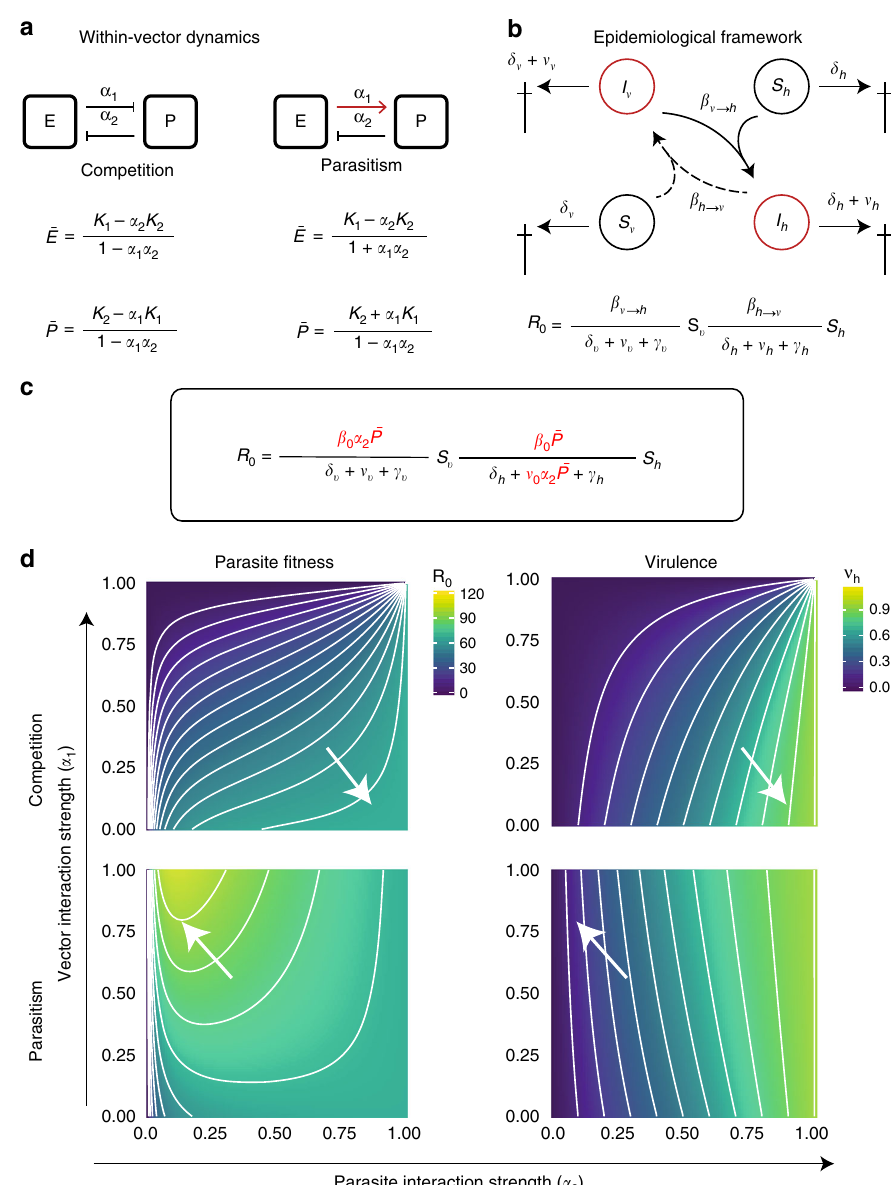
Fig. 1 Within-vector dynamics affect the evolution of within-host virulence. a Schematic representation of the within-vector model. Inside the mosquito, eggs ( E ) and parasite ( P ) allocate resources for their development, interacting in an either competitive (left) or parasitic manner (right). The densities of developed parasites and eggs depend on how strongly eggs and parasites interact with each other (i.e., their interaction strengths α 1 and α 2 ) and are determined by the steady states (cid:1) E and (cid:1) P . b Schematic representation of the epidemiological model in a human host population, where infected vectors I v (red) transmit the parasite to susceptible humans S h (black) at a rate β (solid arrows) and infected humans I h (red) transmit the disease to susceptible v ! h mosquitoes S v at a rate β (dashed arrows). For both populations, their natural death rate ( δ h and δ v ) is increased by a factor ( ν h and ν v ) representing the h ! v parasite-induced virulence. The fi tness of the parasite is then given by the basic reproduction number ( R 0 ), which is proportional to the parasite ’ s infectivity and the duration of the infection. c Nested model is based on the assumption that transmission rate and virulence are affected by the interactions between eggs and parasites within the vector. d The fi tness of the parasite ( R 0 , left column) and its virulence in the human host ( ν h , right column) were calculated for various values of α 1 and α 2 assuming both a competitive (upper row) and a parasitic (lower row) scenario. The values of R 0 and ν h are shown in the color bar from highest (lime green) to lowest (dark purple). The white arrows in the left panels point to the contours with the highest value of parasite fi tness ( R ν 0 ) and those in the right panels to their corresponding virulence values in the human host ( h ). Note that an optimal value in R 0 is observed only in the parasitic scenario occurring at low virulence values. The parameter values used in this model are fully described in Supplementary Table